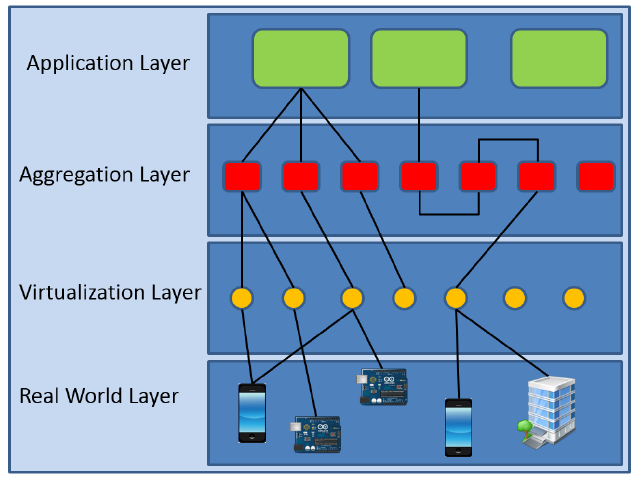
Figure 1. The considered four-layer model for IoT